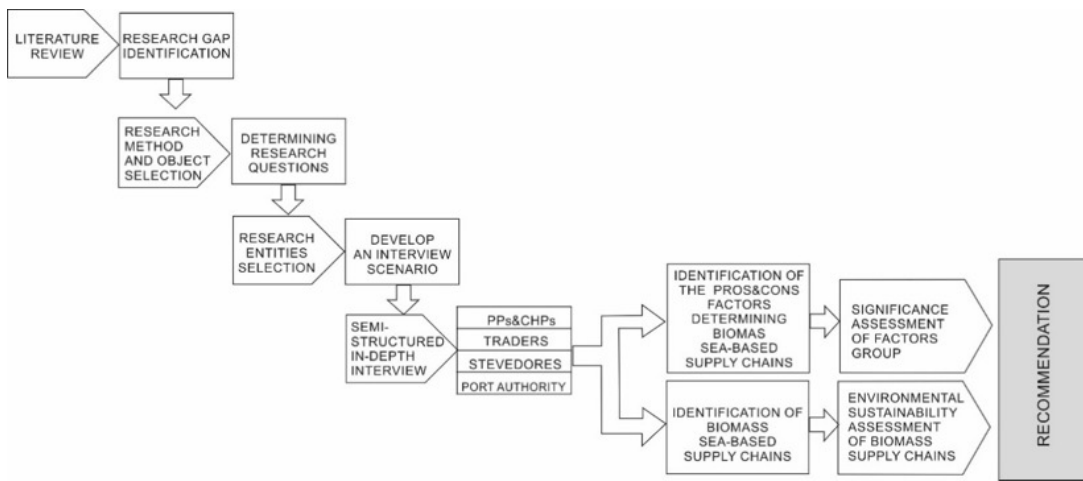
Figure 2. The main steps of the research process.